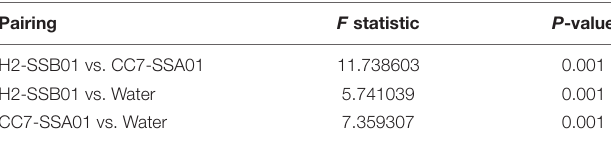
TABLE 1 | Summary statistics of PERMANOVA based on Bray–Curtis dissimilarity of bacterial taxa abundances (OTUs) for seawater and host-algal symbiont